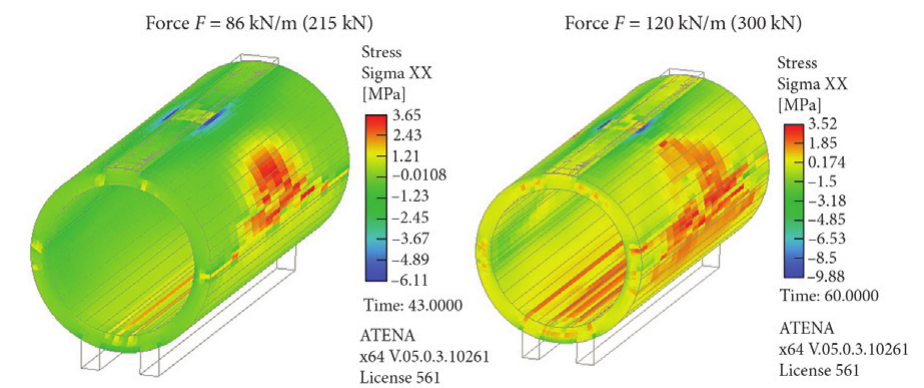
Fig. 10. Stress distribution depending on the applied load